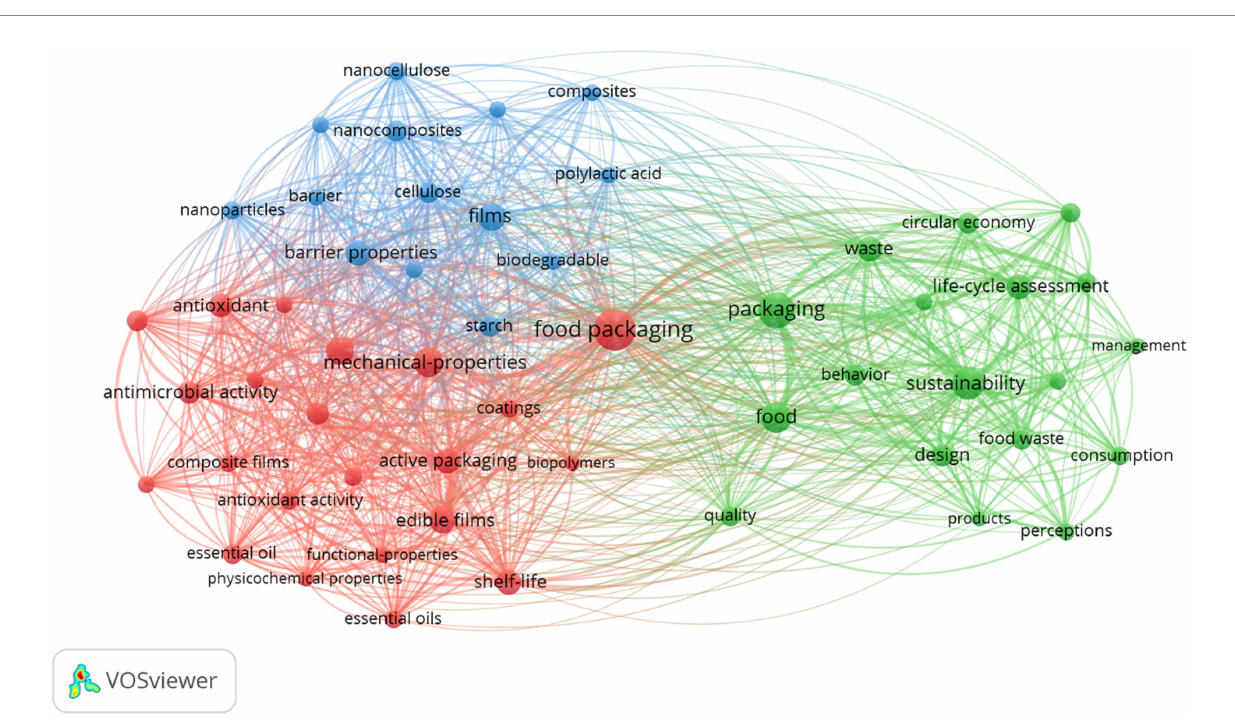
FIGURE 2 Co-occurrence analysis of the most relevant papers in literature. Size of the nodes represent more frequently used terms. Different colors represent different clusters. The minimum number of terms is 10, at least 30 times occurring /terms.